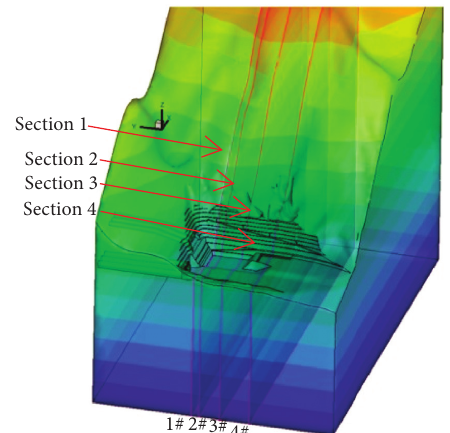
Figure 5: Typical section position of the